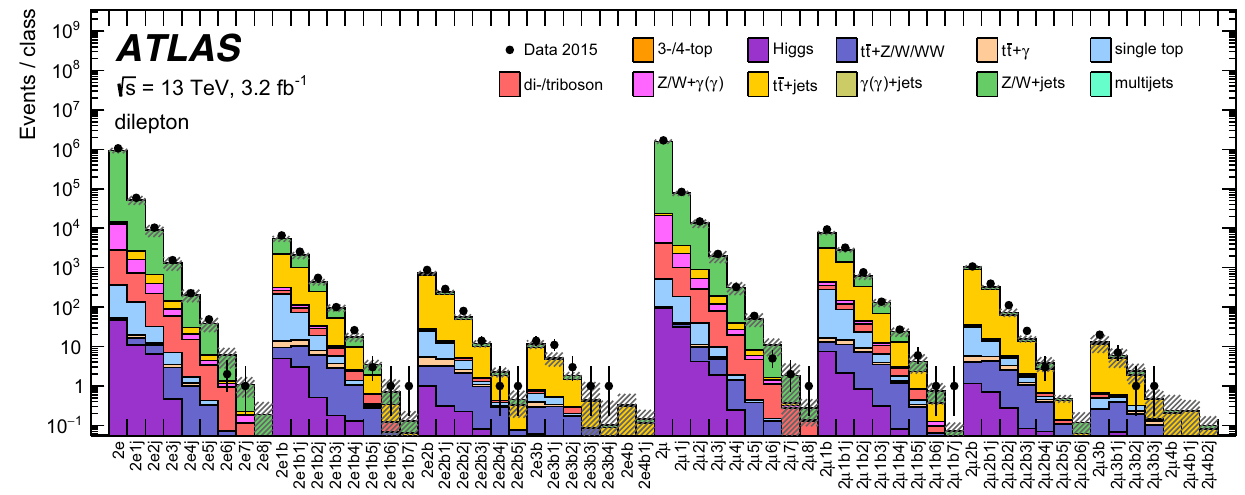
Fig. 15 The number of events in data, and for the different SM back- ing to the multiplicity and type ( e , μ , γ , j , b , E miss ground predictions considered, for classes with two same-flavour lep- objects for the given event class. The hatched bands indicate the total tons and ( b -)jets (no photons or E miss uncertainty of the SM prediction ). The classes are labelled accord- T